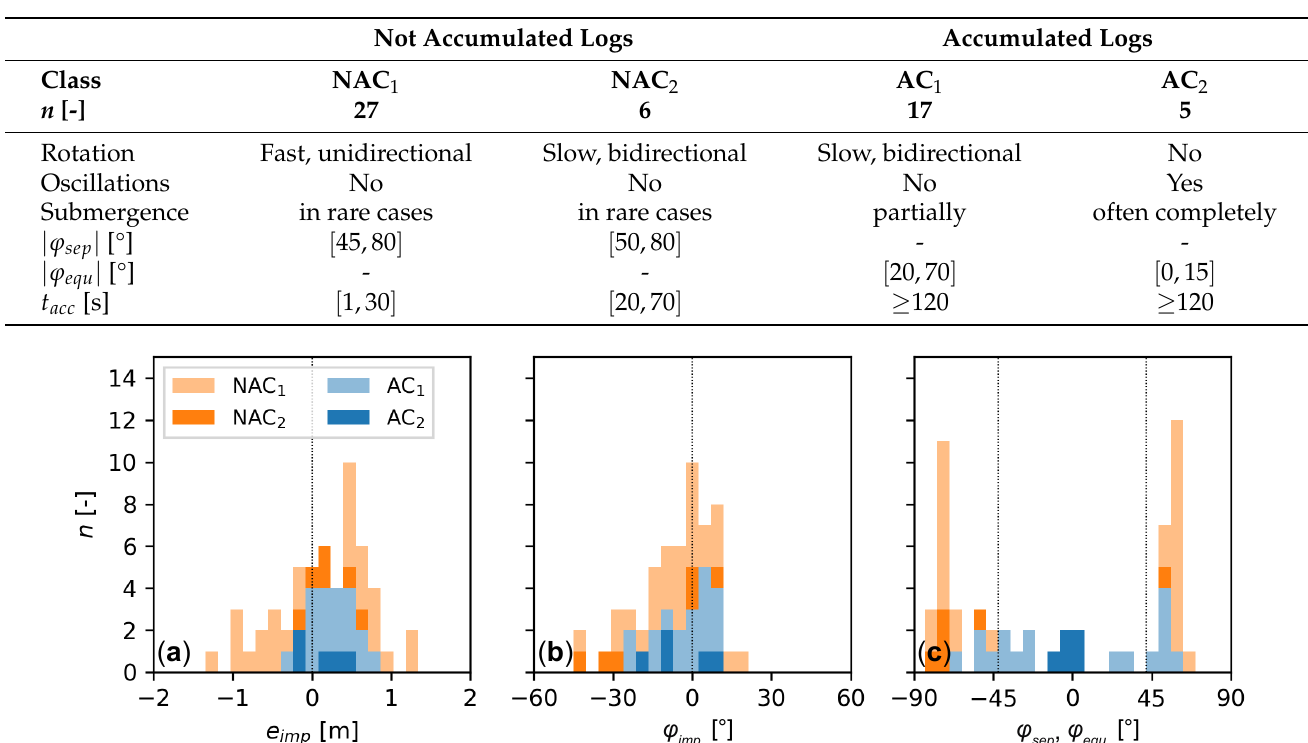
Table 2. Observed movements of accumulated (AC 1 , AC 2 ) and not accumulated logs (NAC 1 , NAC 2 ) during rotation phase.